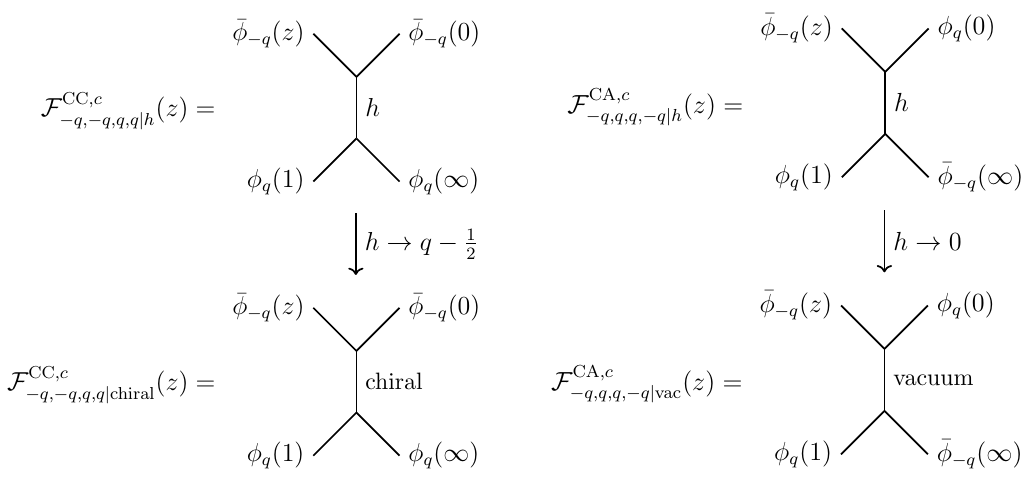
Figure 2. The limits that relate = 2 super-Virasoro blocks with BPS external primaries and N non-BPS as well as BPS internal